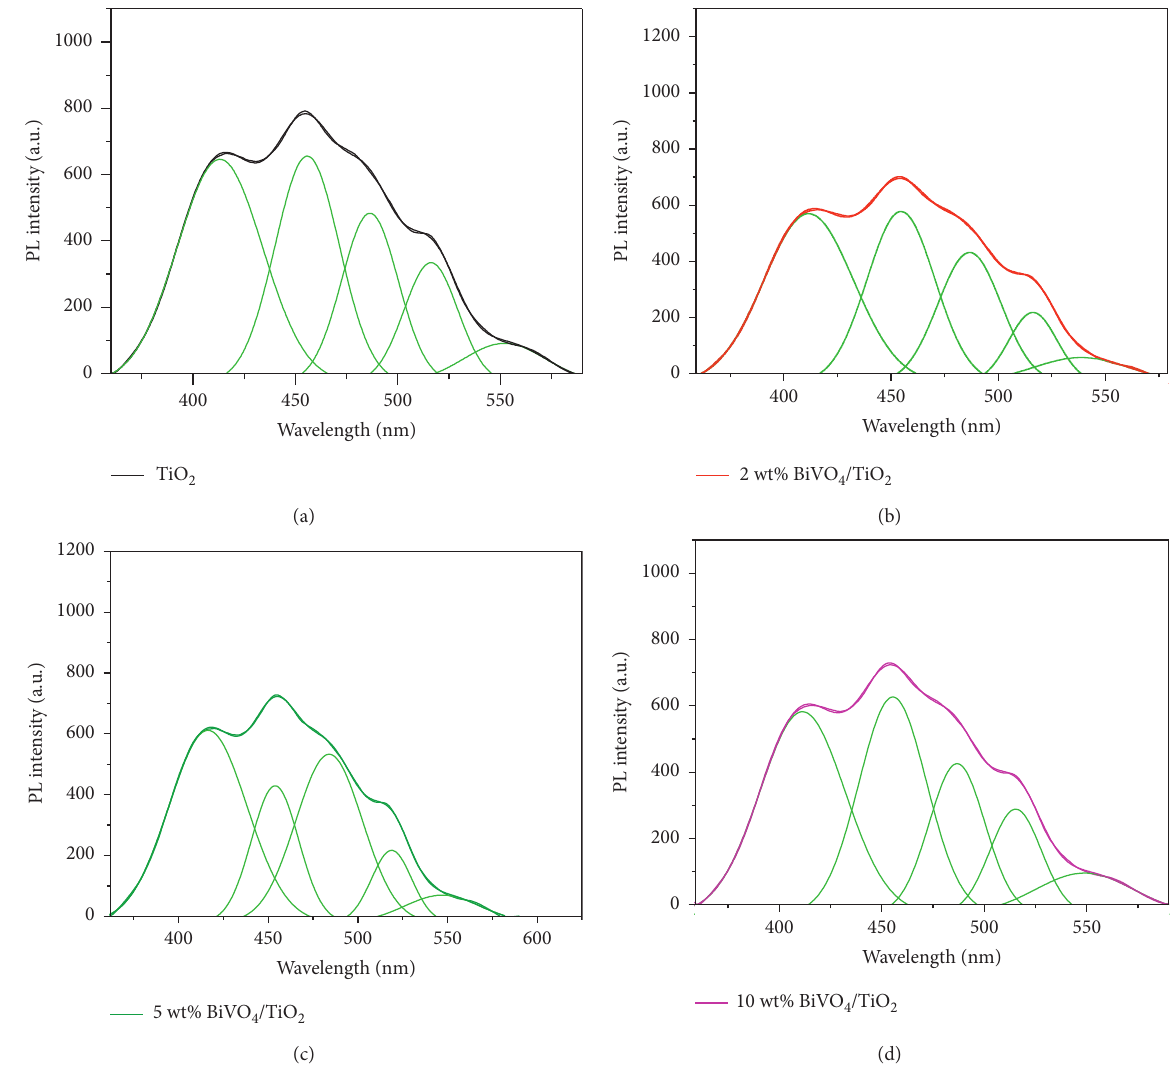
Figure 11: Deconvoluted photoluminescence spectra of (a) TiO 2 , (b) 2 wt% BiVO 4 /TiO 2 , (c) 5 wt% BiVO 4 /TiO 2 , and (d) 10 wt% BiVO 4 /TiO 2 .